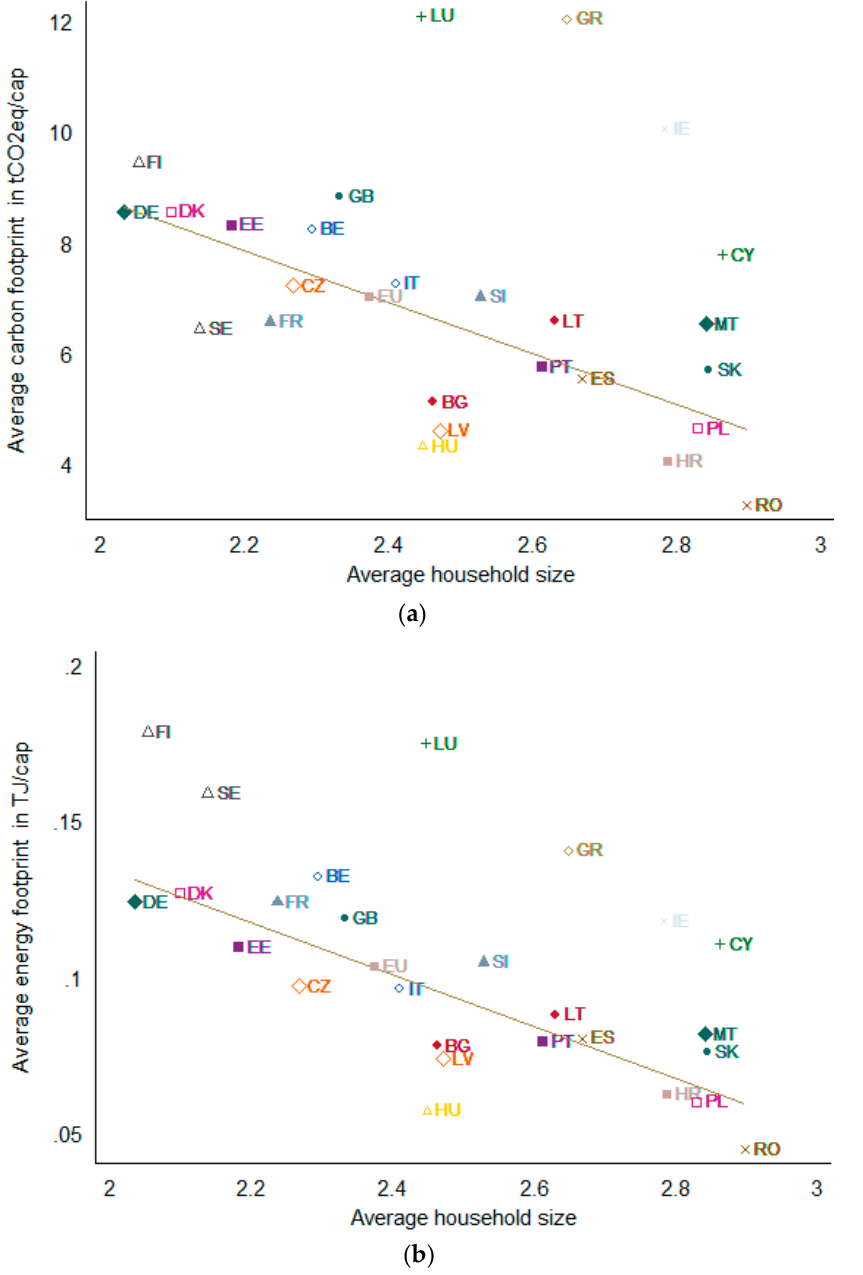
Figure 2. Association between average household size and average per capita carbon ( a ) and energy ( b ) footprints in the EU. The carbon footprints are measured in tCO 2 eq/cap and energy footprints in TJ/cap. Household weights provided by the HBS have been applied.